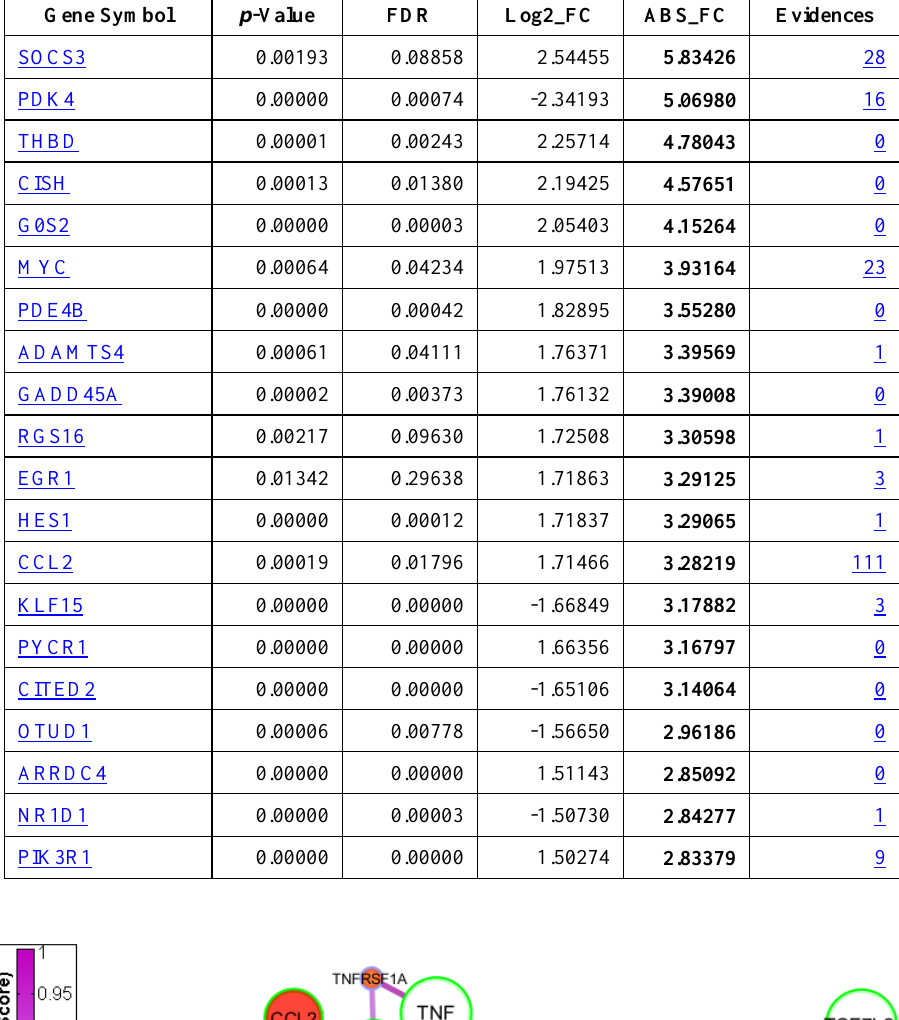
Table 1: Top-20 differential genes in IBB from GSE24215, ordered by FC, (FC>=1.3, p-value <=0.05 and AEL >=40% after applying Limma package in Bioconductor). Note: Gene names are linked to GeneCards.org, UniProt IDs are linked to UniProt.org, and Evidences are linked to PubMed.